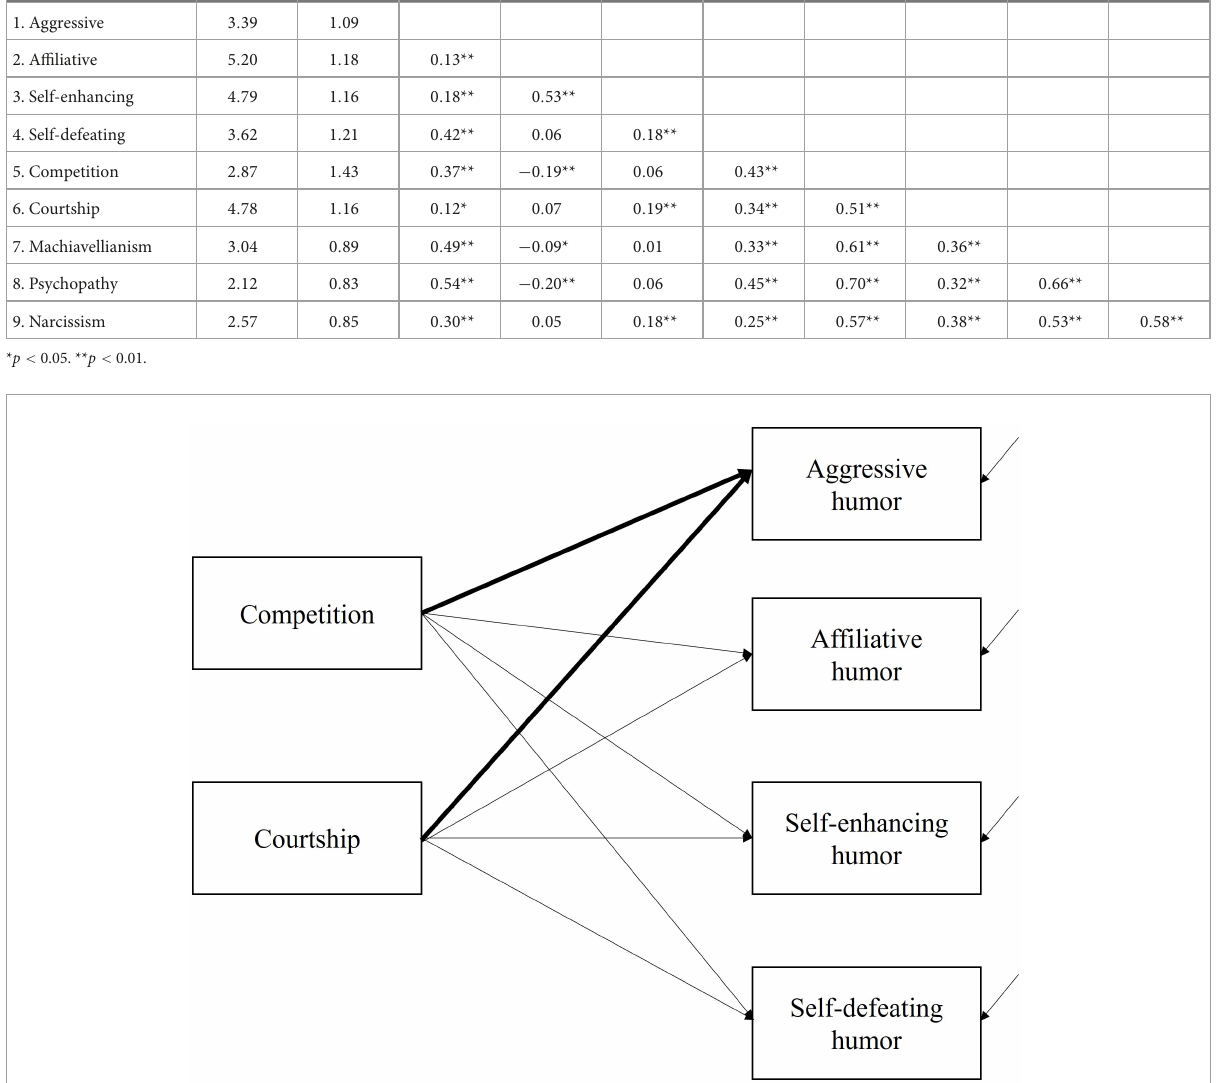
FIGURE1 Regressing self-reported use of aggressive and other types of humor of motives of competition and courtship in a path model. Thicker arrow lines indicate focal paths. Arrow lines pointing toward the four types of humor represent residual terms. The covariances of the residual terms were controlled for in model estimation but omitted in the figure for clarity of